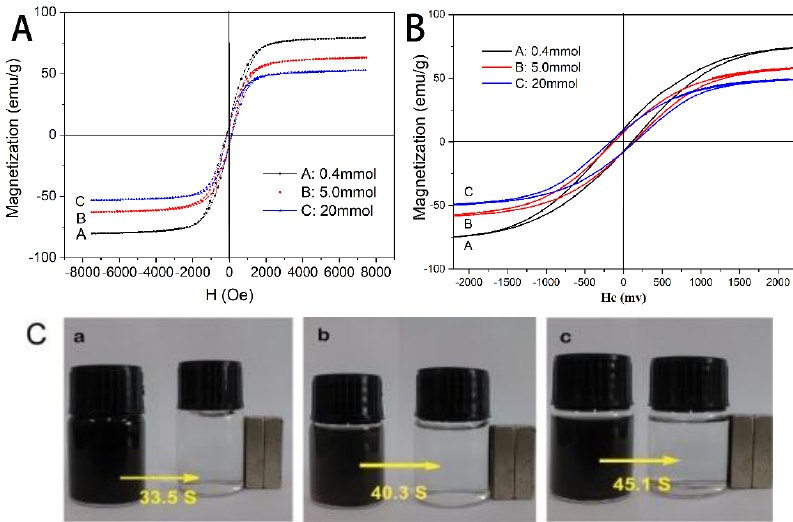
Figure 4. The hysteresis loops at T = 300 K of Fe 3 O 4 ( A ) and corresponding partly amplification images ( B ) with different molar ratio of FeCl 3 ·6H 2 O ( a ) 0.4 mmol, ( b ) 5 mmol, ( c ) 20 mmol; ( C ) photograph of magnetic isolation.